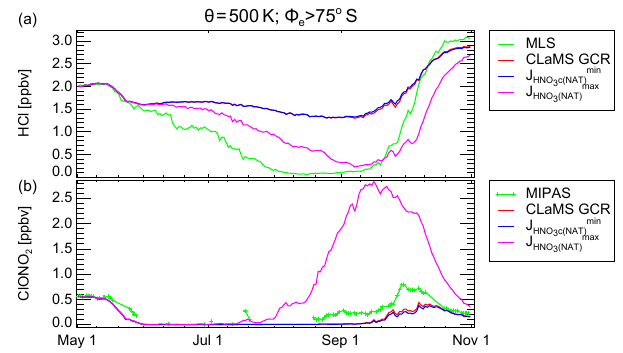
Figure 12. As Fig. 10 but for CLaMS simulation with hypothetical NAT decomposition. CLaMS results are shown for the GCR simu- lation (orange) and the NAT decomp simulation